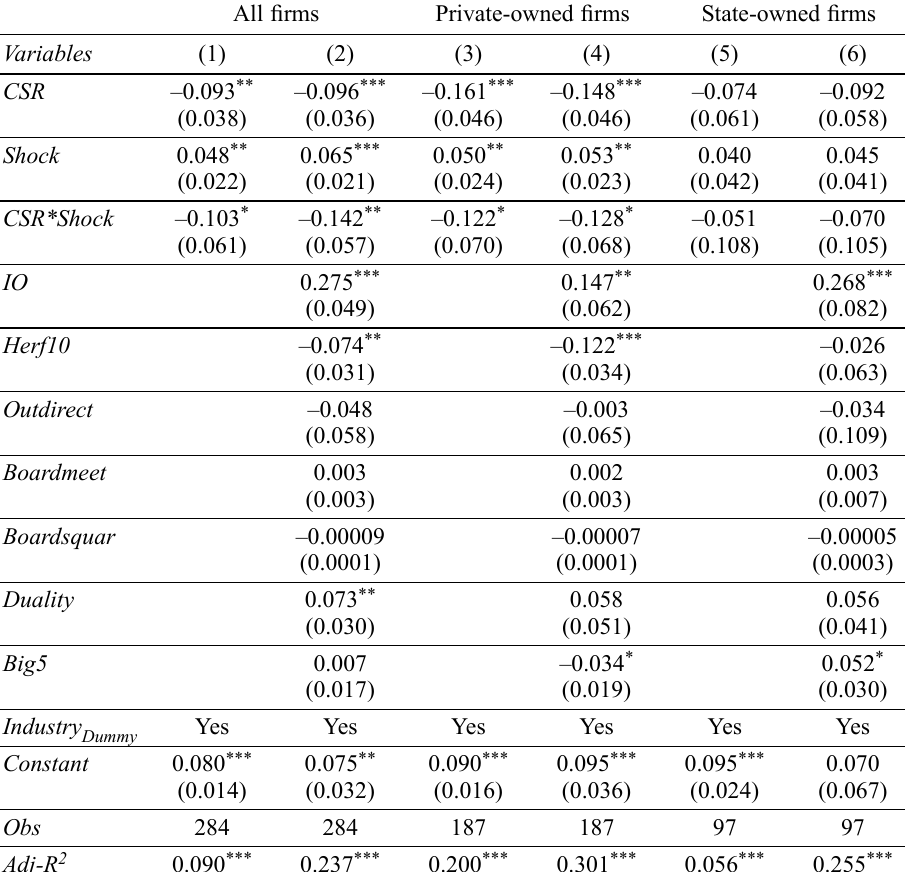
Table 4. Shocks of exogenous CSR -events on minority shareholder participation All firms Private-owned